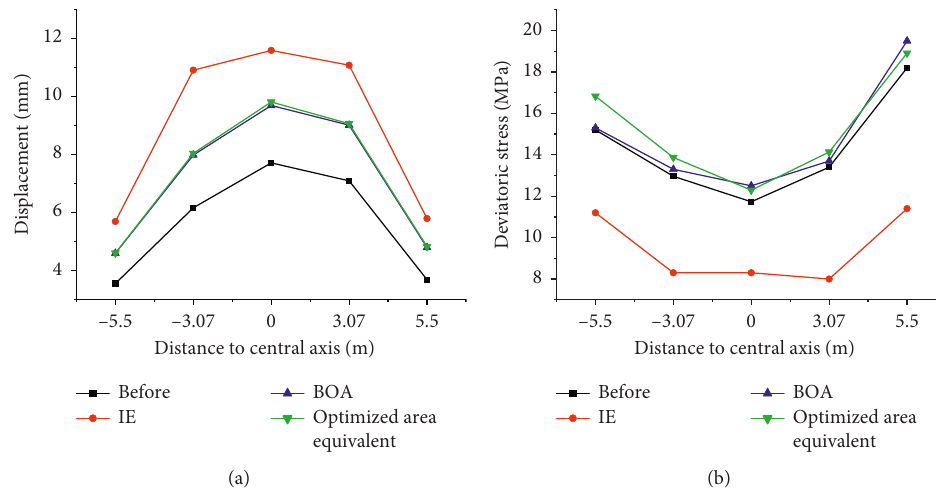
Figure 17: Comparison of three equivalent methods. (a) Displacement at each key point of surrounding rocks. (b) Deviatoric stress at each key point of surrounding